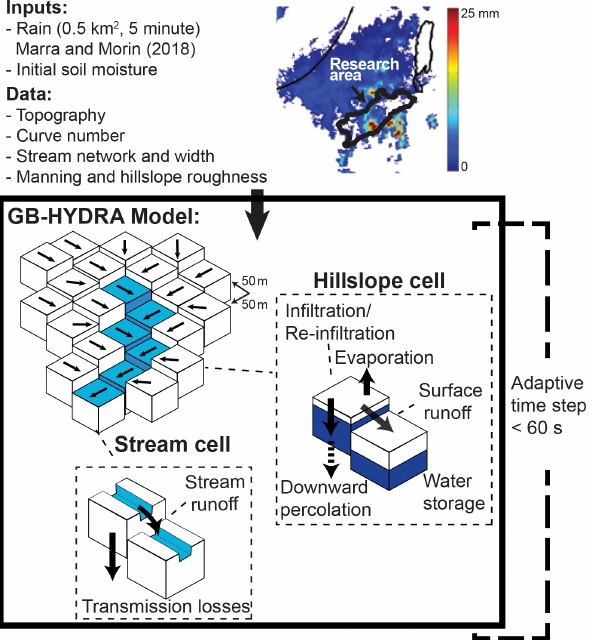
Figure 4. The modified GB-HYDRA model scheme, processes, and inputs. Further details are given in Appendix A and in Rinat et al. (2018).